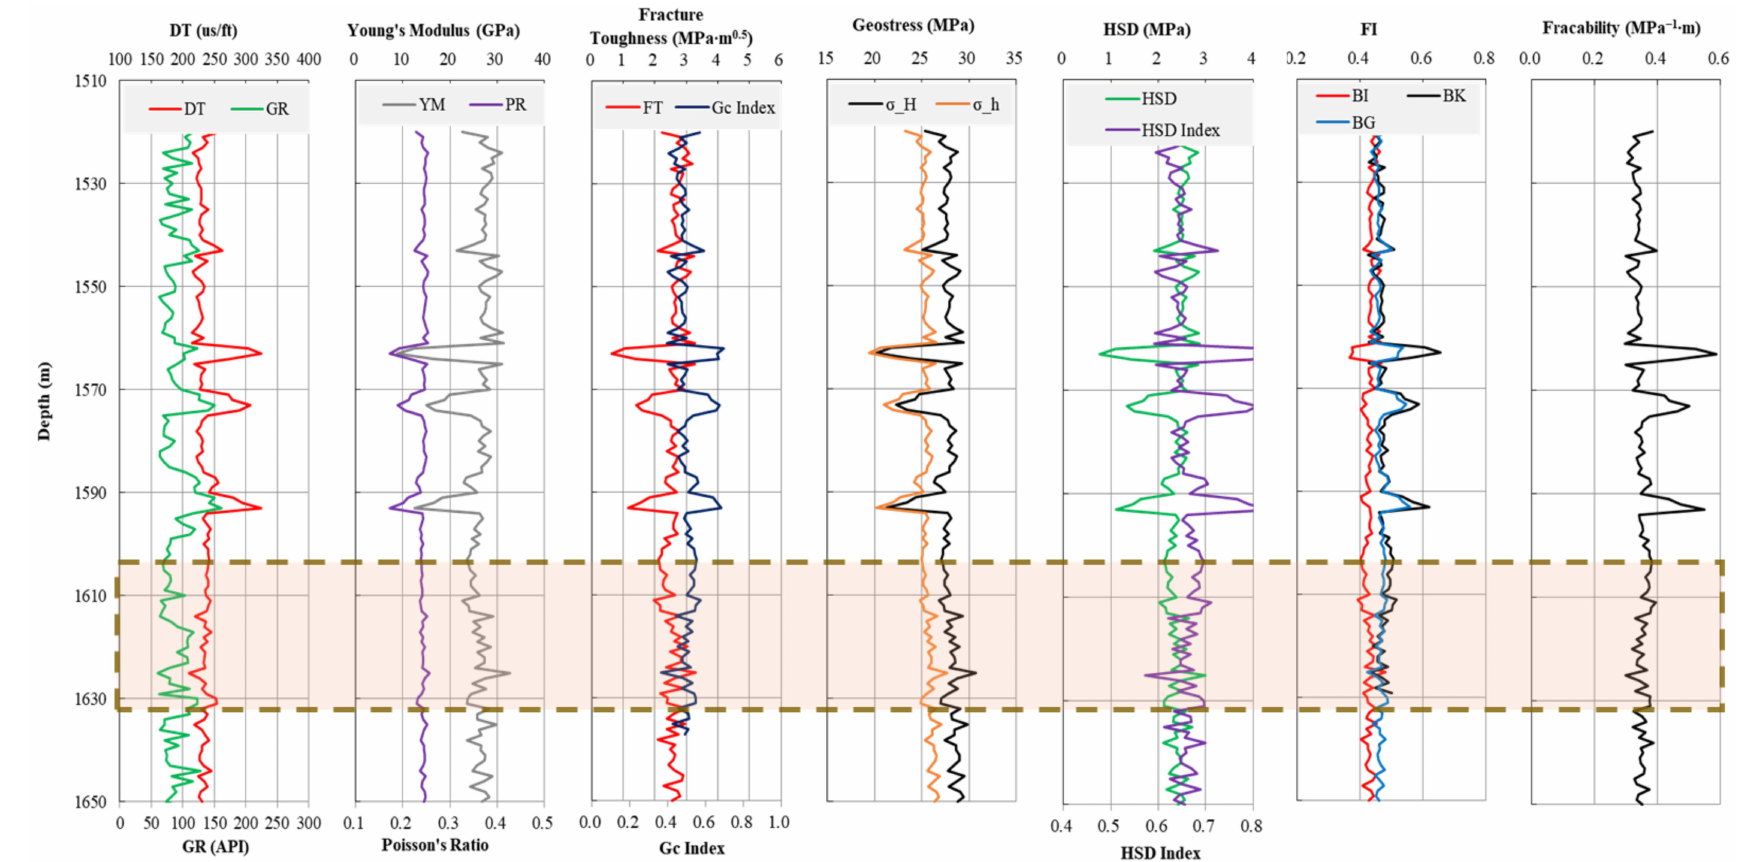
Figure 7. Profiles of fracability and other key parameters from Well